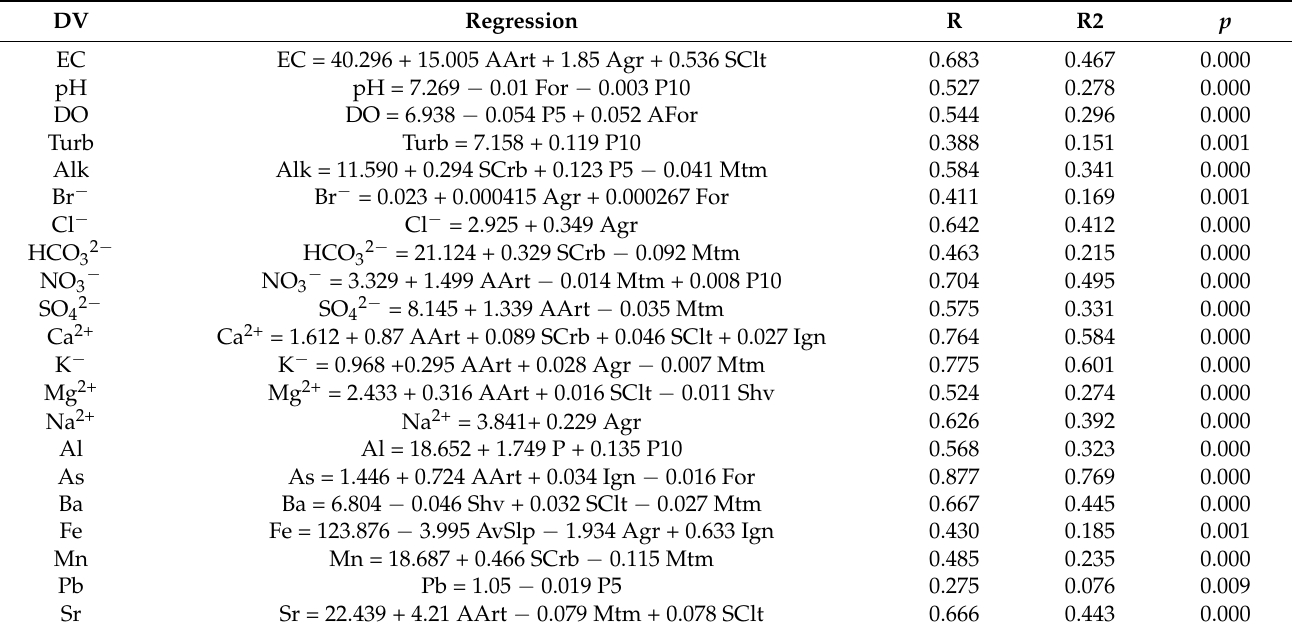
Table 5. Multiple regression analysis models between natural and anthropogenic factors and the water states of the Mondego River for the studied